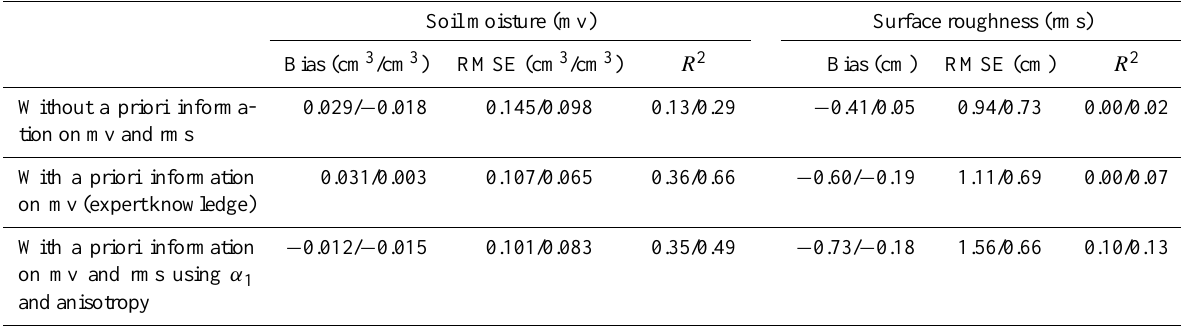
Table 3. Inversion approach results for RADARSAT-2 data. The format of results is “a/b”, where “a” corresponds to statistics using a noise of ± 0.5 dB, and “b” corresponds to statistics using a noise of ± 1.0 dB. The neural networks trained with data generated at incidence angles of 35 ◦ and 45 ◦ were used for images acquired at incidence angles near of 35 ◦ and 45 ◦ , respectively. Soil moisture (mv) Surface roughness (rms) Bias (cm 3 /cm 3 ) RMSE (cm 3 /cm 3 ) RMSE (cm) 0.029/ − 0.018